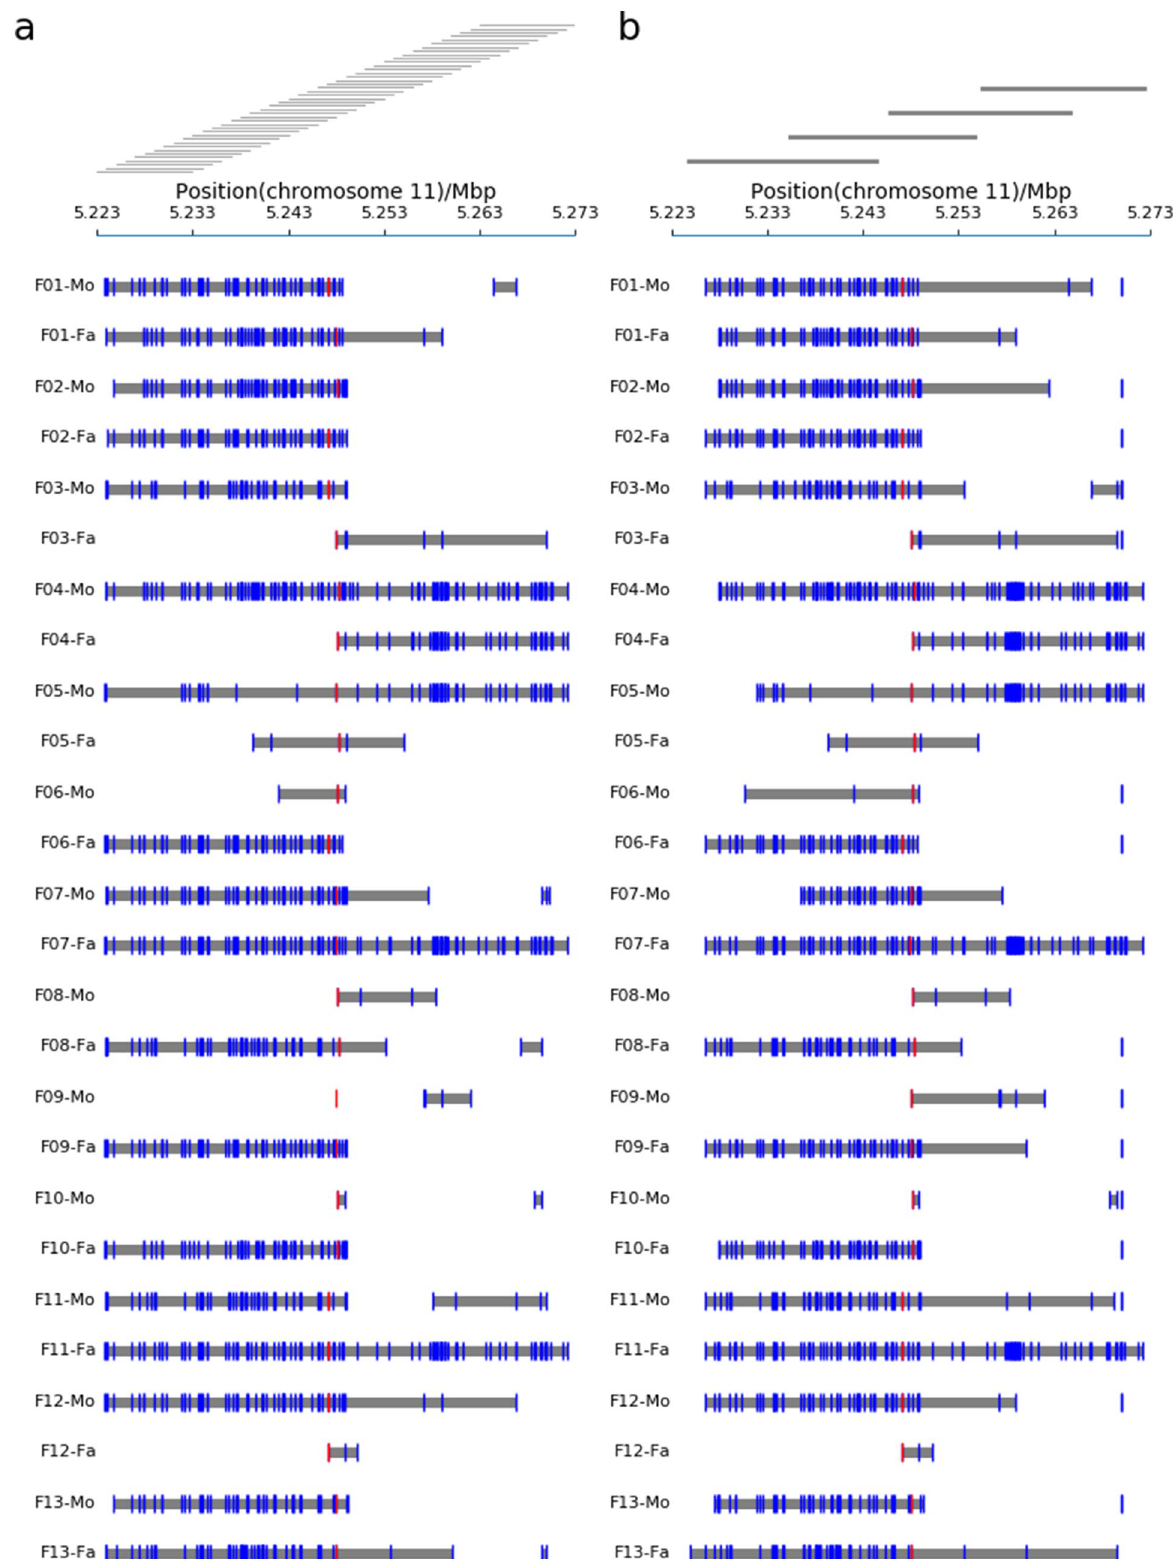
Figure 2. Haplotype phasing results of targeted region for all 13 families using 10 kb (a) and 20 kb (b) libraries, respectively. Haplotype blocks are represented by gray line. Vertical blue lines indicate the SNPs. Vertical red lines indicate the mutation